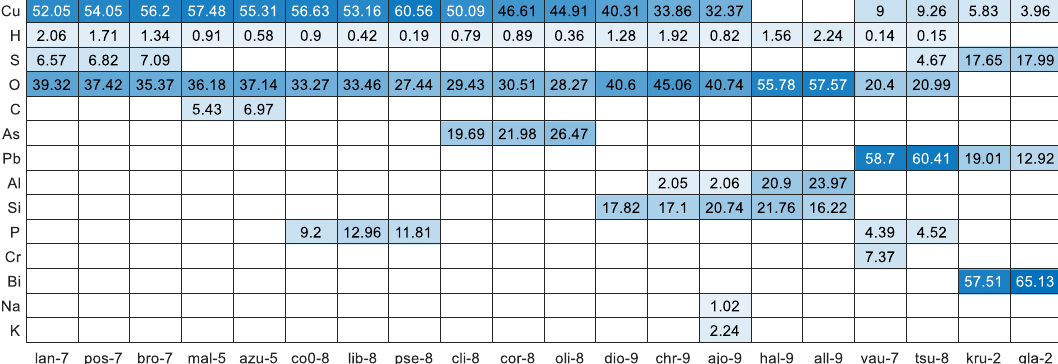
Figure 3. Heatmap (with values) representing elemental composition among the most similar minerals in accordance with the mineral’s empirical formula [24]. The sorting from left to right was performed based on the outcome of Figure 2.